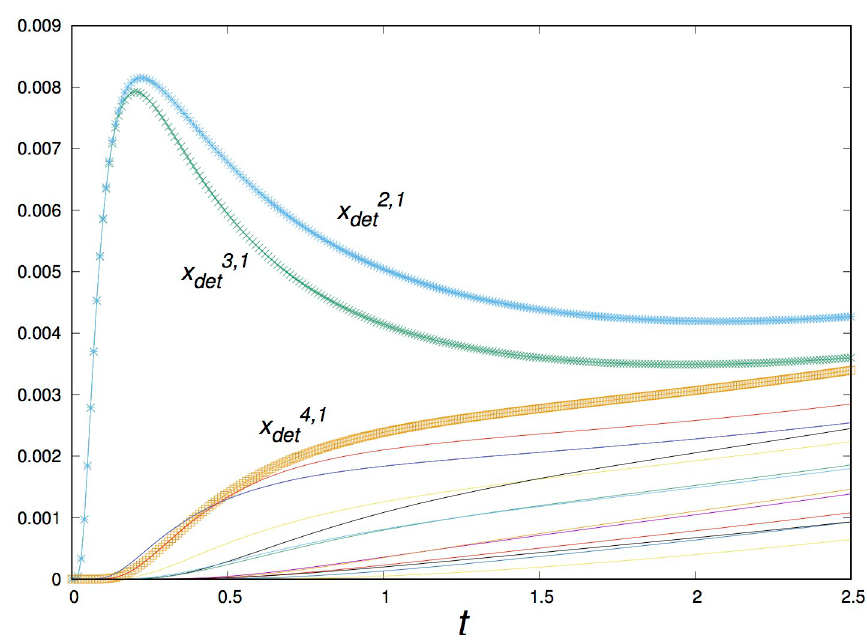
Fig 5. Time series of the variable u measured at the 16 detectors u ð x k ; l 0.95, ρ 0 = − 0.25, and outbreak centered at x 5 ; 1 time domain.